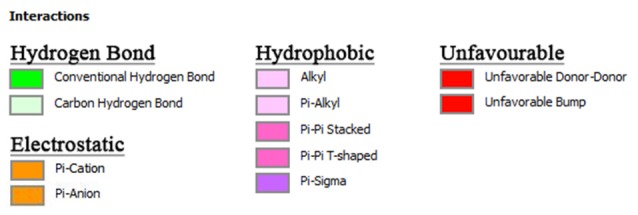
Color coding of non-covalent interactions linking ligand–receptor pairs. The interaction can be categorized into five groups, namely, hydrogen bonds, electrostatic, hydrophobic, and unfavorable linkage.